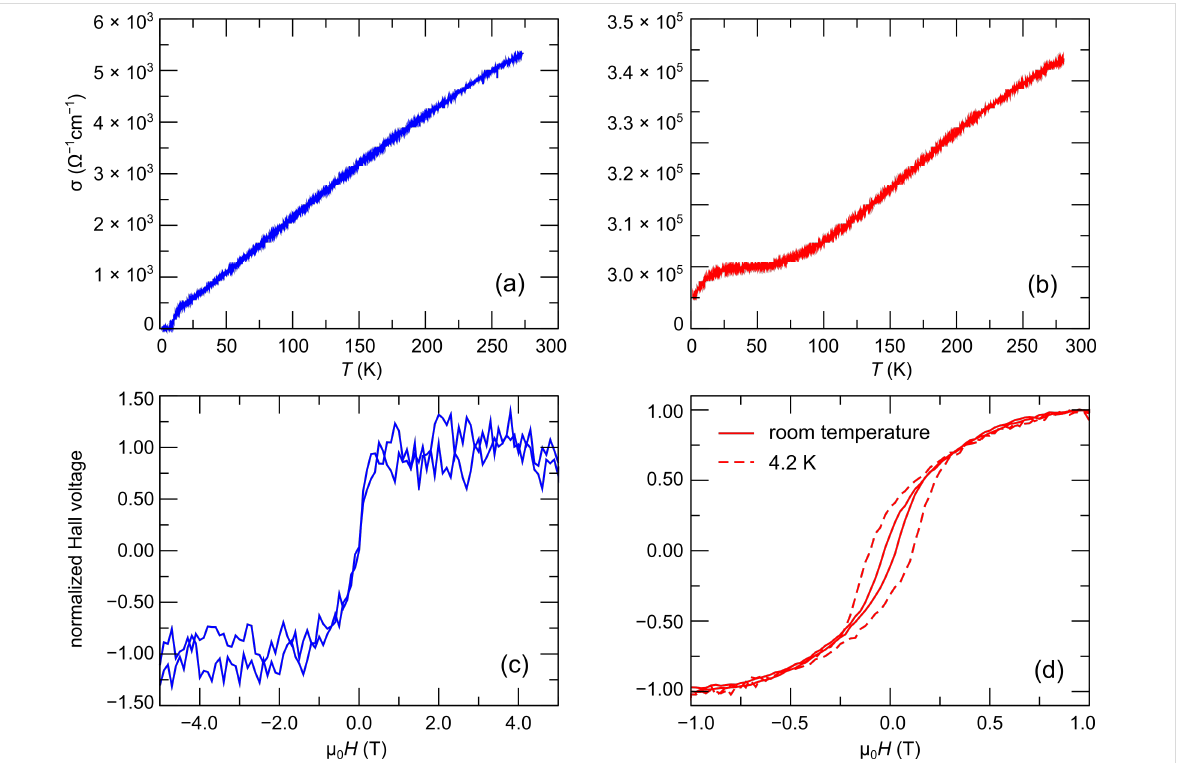
Figure 10: Temperature-dependent conductivity and Hall effect as a function of the applied magnetic field for samples B (a,c) and B' (b,d). The Hall data shown in (c) were taken at 228 K. Adapted from